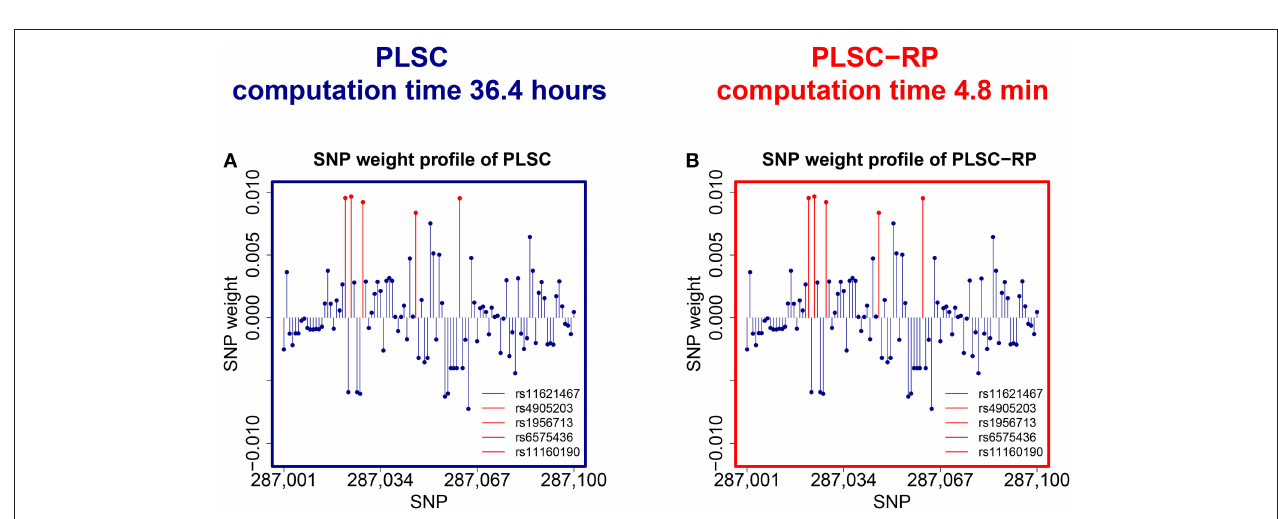
FIGURE 3 | SNPs associated with serum vaspin concentration in the Sorbs. (A) SNP weight profile of PLSC applied to the original data set consisting of 359,845 SNPs. (B) SNP weight profile of PLSC-RP after dimensionality reduction of the SNP data set to 865 dimensions. Reliable SNPs according to bootstrapping are plotted in red. For visualization purpose, the SNP weight profiles are zoomed in on a range representing causal